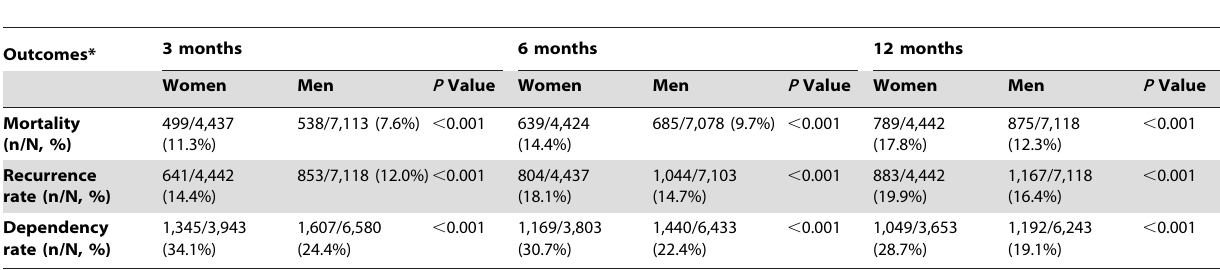
Table 3. Clinical outcomes at 3, 6, and 12 months after ischemic